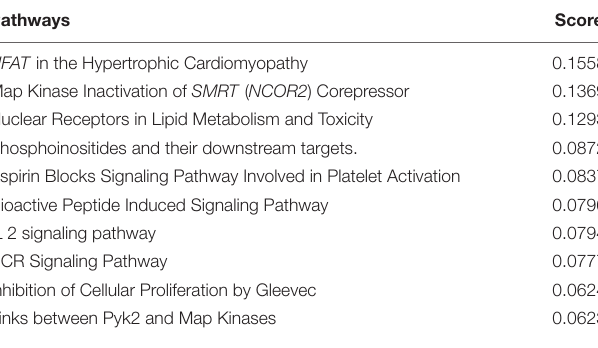
TABLE 1 | The top 10 pathways related to Schisandra in the treatment of